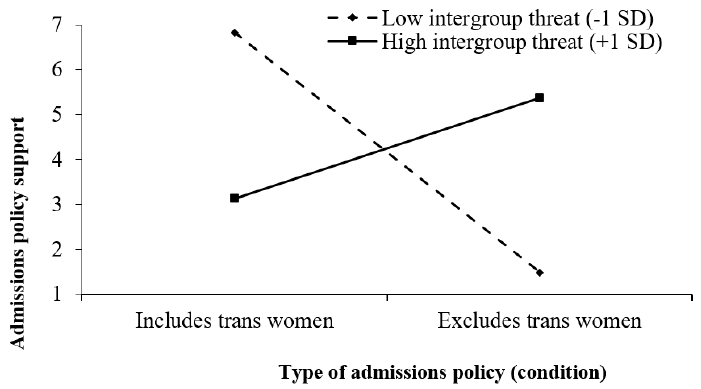
Figure 1. The effect of admissions policy type and intergroup threat on support for the admissions policy (controlling for participant age, household income, education level and religiosity).